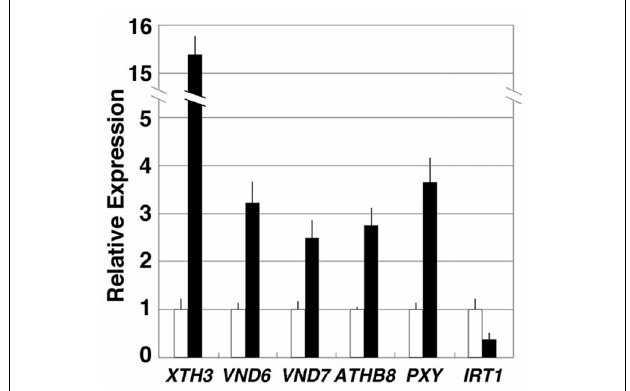
FIGURE 1 | Expression levels of selected genes altered in acl5-1 . Total RNA was prepared from 7-day-old wild-type (Col-0) and acl5-1 seedlings, and analyzed by quantitative real-time RT-PCR. All transcript levels in acl5-1 (black bars) are relative to those in the wild type (white bars). ACTIN8 transcripts were used as internal control. Error bars represent the SE ( n = 3).